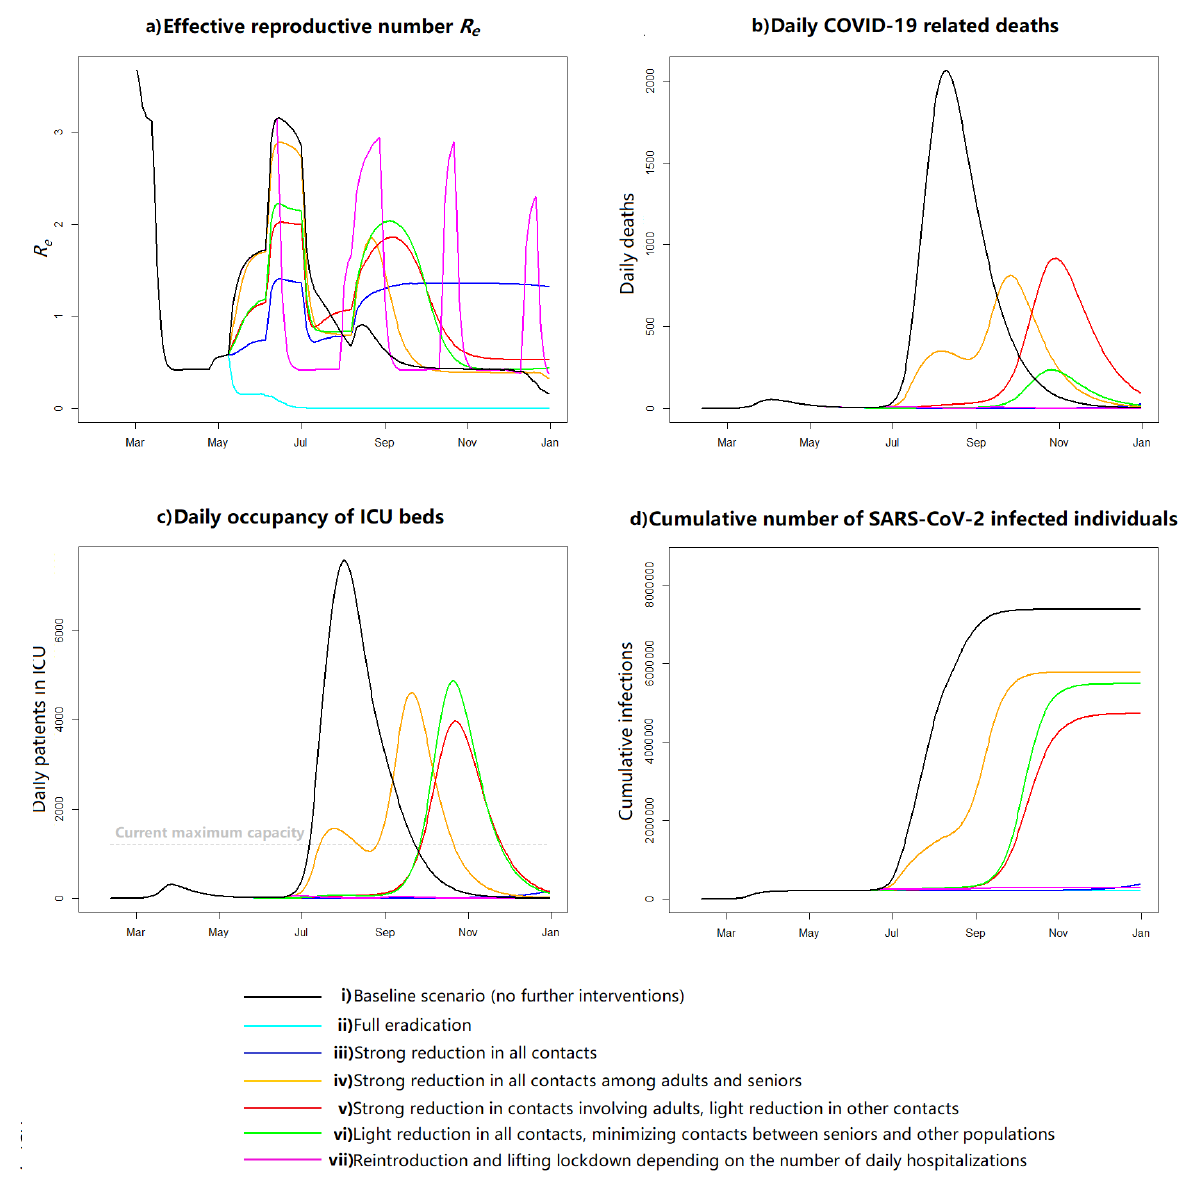
Figure 1. Results from different scenarios. a ) Reproductive number, b ) daily COVID-19 related deaths, c ) daily intensive care unit (ICU) bed occupancy, and d ) cumulative infections in Switzerland from 11 February to 31 December 2020. “Full eradication” refers to a 76% reduction of contacts (calibrated to eradicate the edpimic by end of July with 90% probability), “strong reduction” refers to a 54% reduction of contacts (calibrated to prevent ICU overflow with 90% probability), “light reduction” is half of that, and “minimizing contacts” refers to 95% reduction of